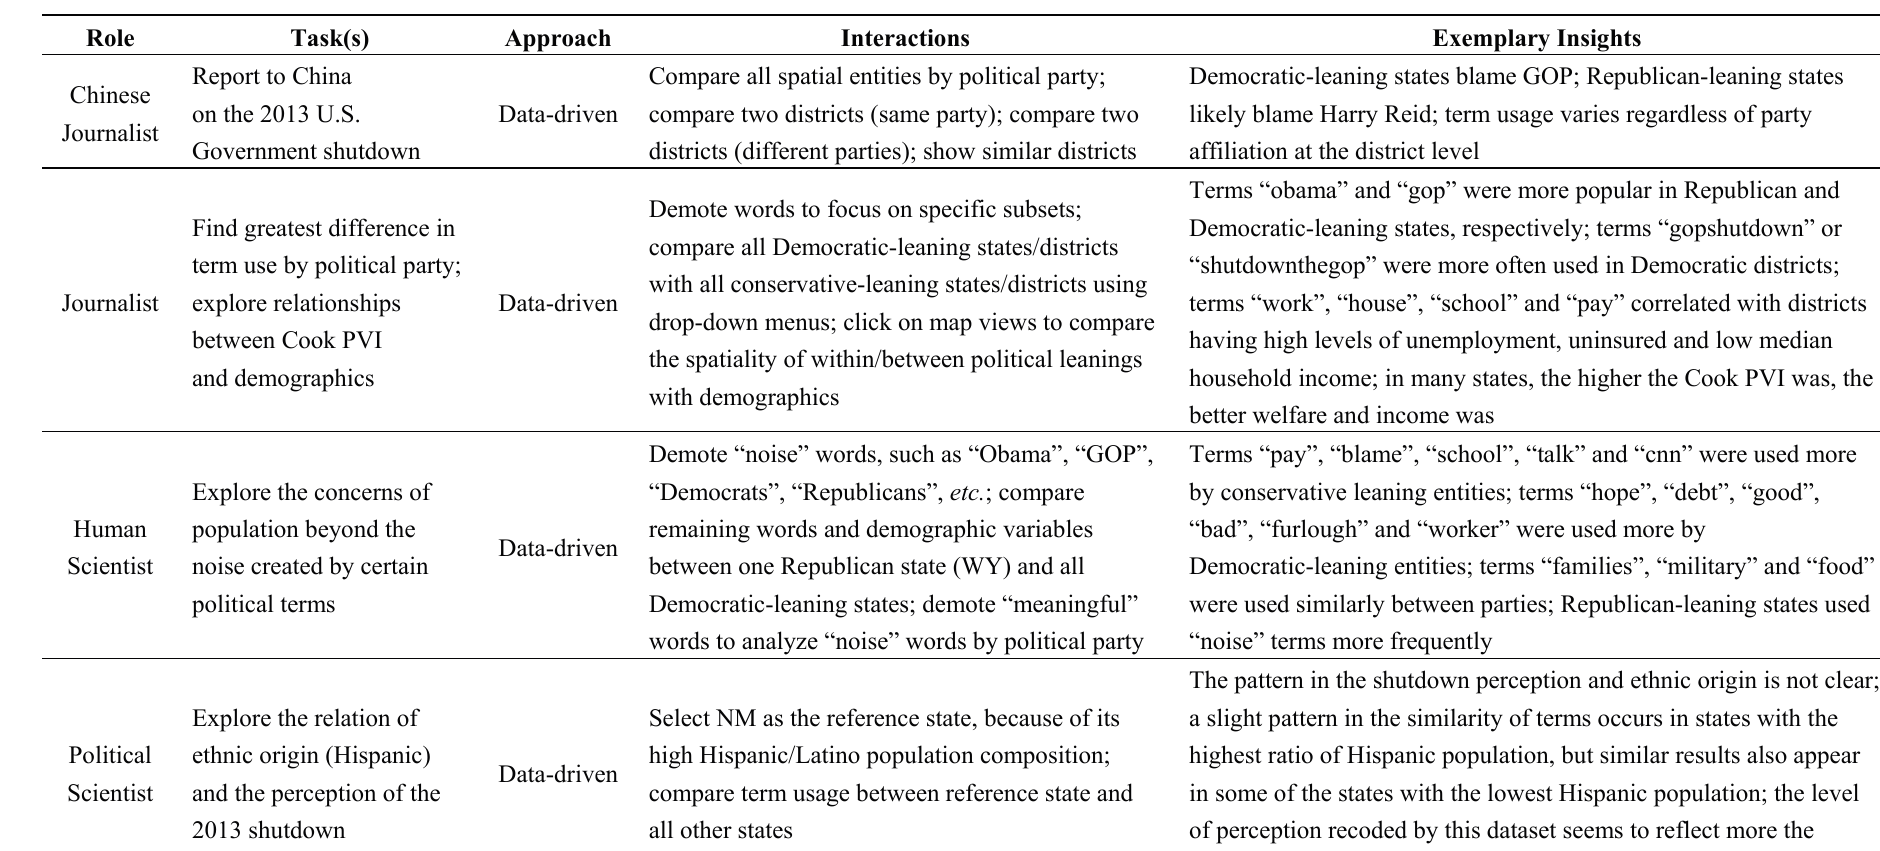
Table 3. Data-driven approaches to insight